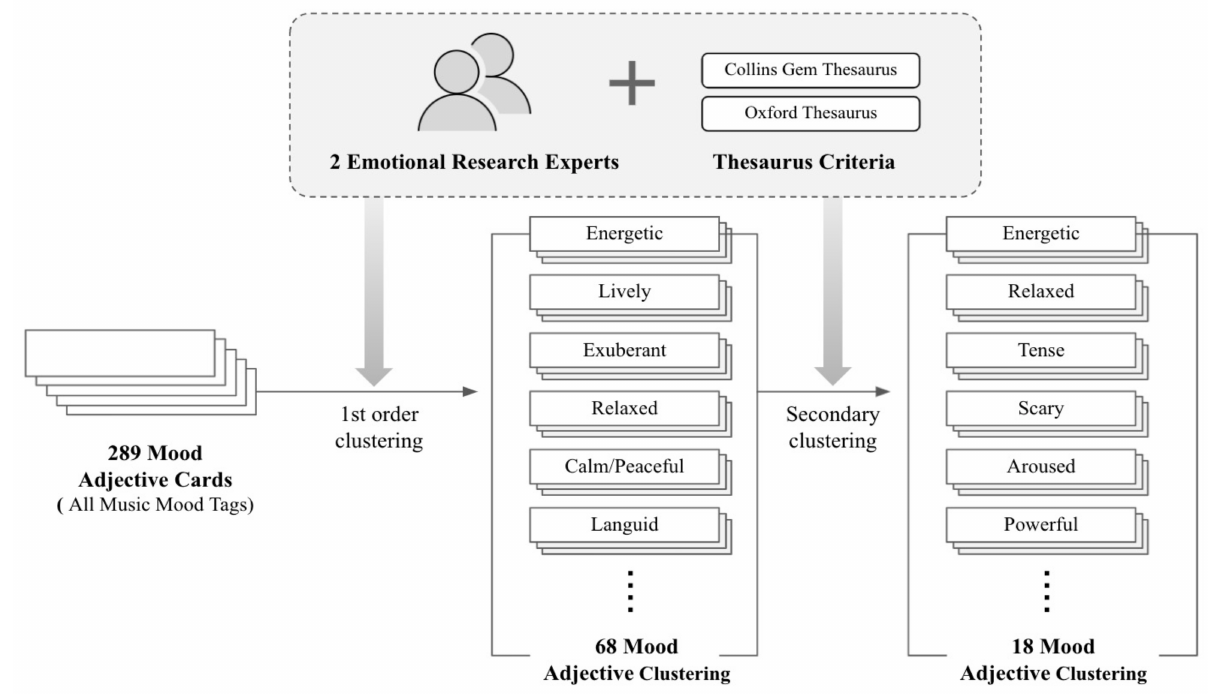
Figure 7. Classical Music Mood Adjective Clustering